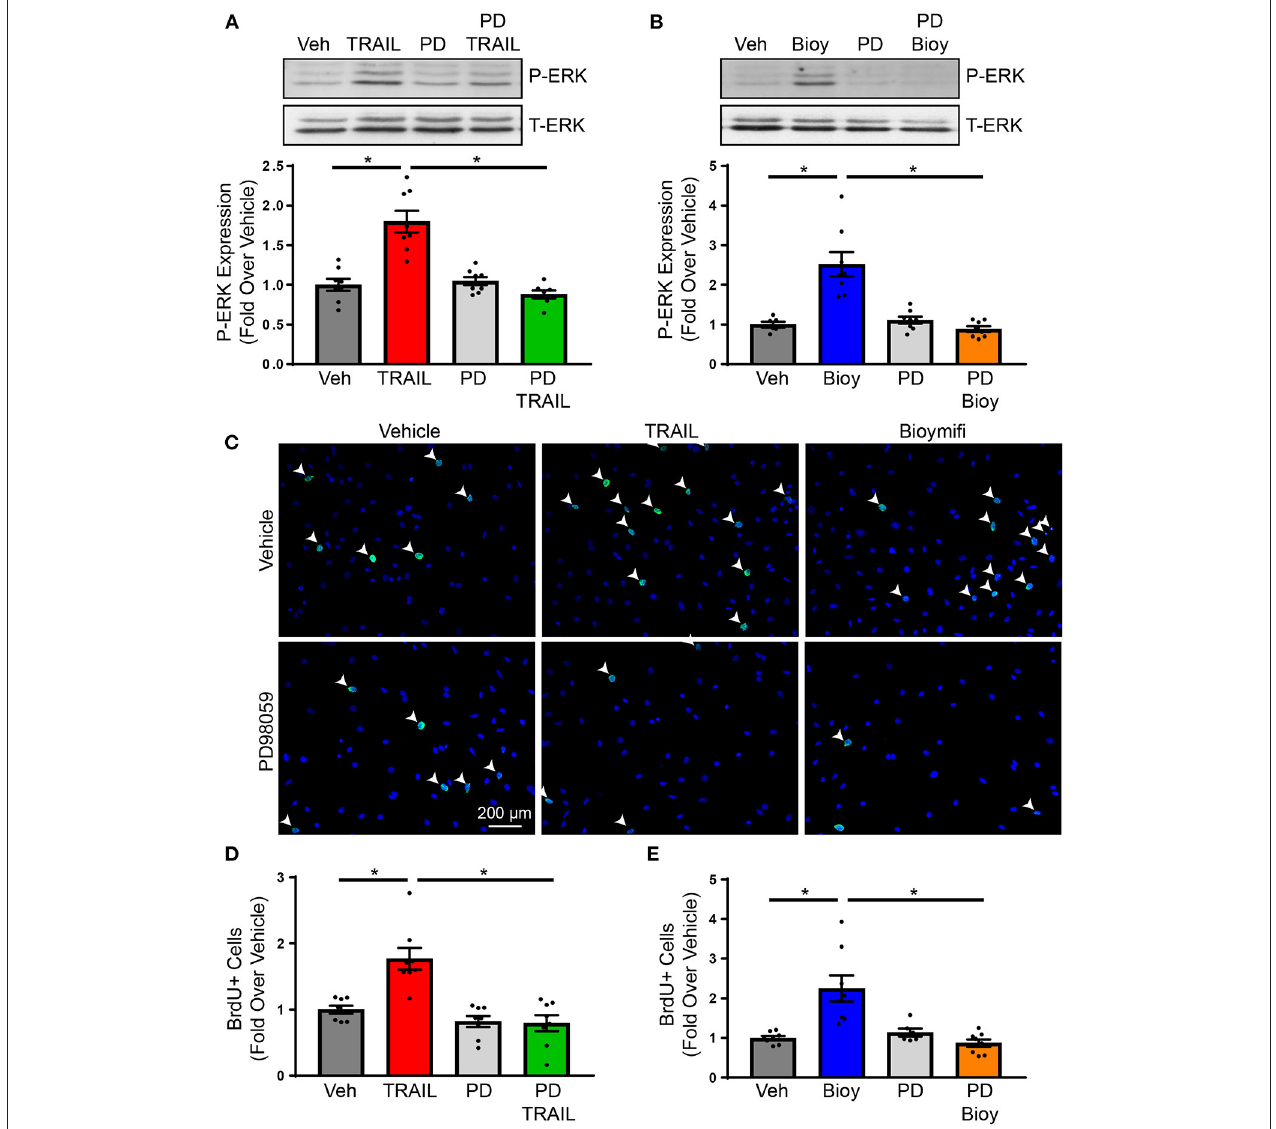
FIGURE 2 | DR5-mediated changes in proliferation occur through ERK1/2 activation. (A) ERK1/2 activation in response to TRAIL in NRVFs was examined using immunoblot analysis for phospho-ERK1/2 in the presence or absence of PD98059. Total-ERK1/2 is shown as a loading control. n = 8, One-Way ANOVA, * p < 0.05. (B) Phosphorylation of ERK1/2 was examined in bioymifi treated NRVFs in the presence or absence of PD98059. Total-ERK1/2 is shown as a loading control. n = 8, One-Way ANOVA, * p < 0.05. (C) Representative BrdU staining (green) and quantified BrdU staining for TRAIL (D) or bioymifi (E) treated NRVFs with our without PD98059 pretreatment. DAPI staining (blue) is used to show nuclei. White arrows indicate BrdU-positive nuclei. n = 8, One-Way ANOVA, * p <